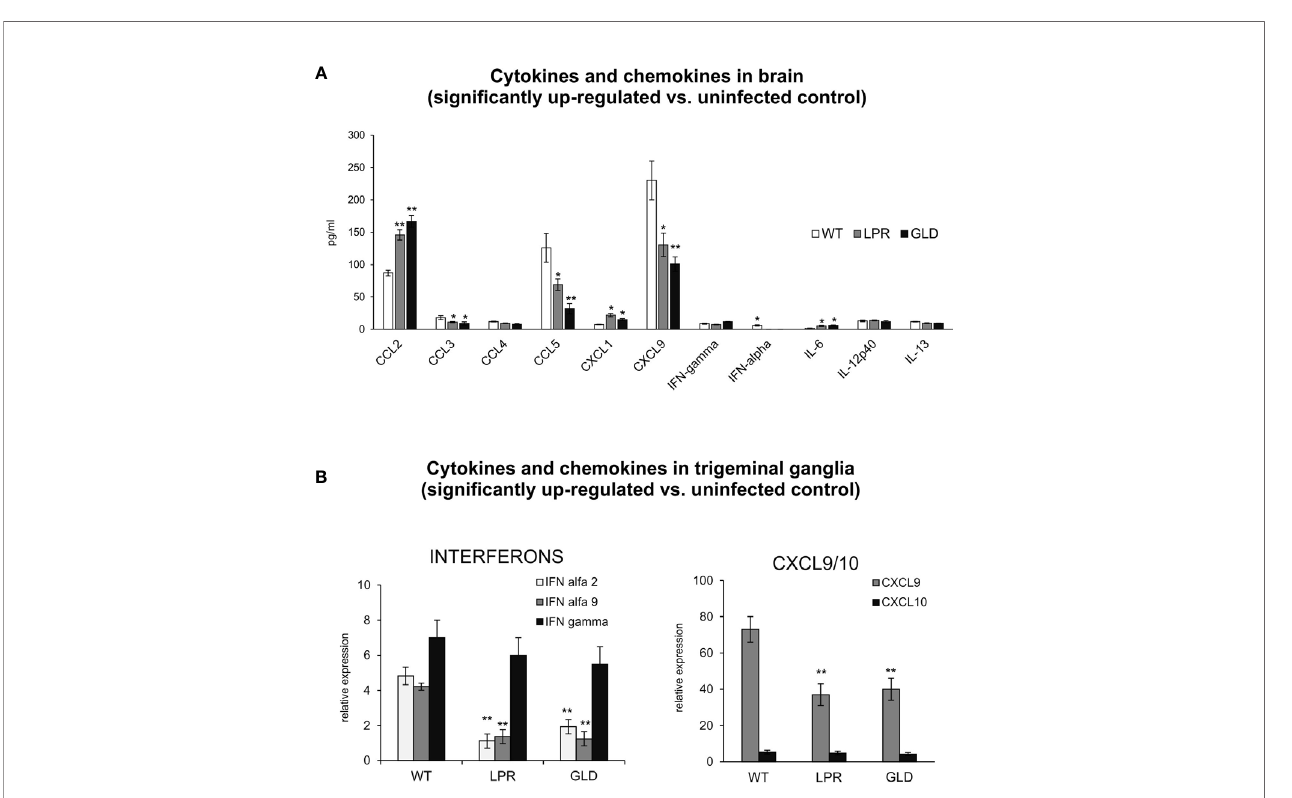
FIGURE 4 | Fas/FasL regulates production of cytokines and chemokines in the HSV-1 infected brain tissue and trigeminal ganglia. (A) Chemokines (CCL2, CCL3, CCL4, CCL5, CXCL1, CXCL9) and cytokines (IFN- a , IFN- g , IL-6, Il-12p40 and IL-13) in the brain tissue at 8 d p.i. were analyzed by Luminex. Data were presented as mean ± SEM, N = 4. Data analysis was performed by comparing Fas-de fi cient (lpr) and FasL-de fi cient (gld) groups with wild-type (C57BL/6) mice. **p ≤ 0.001, *p ≤ 0.05. (B) Interferons (IFN- a 4, IFN- a 9 and IFN- g ) and chemokines (CXCL9 and CXCL10) in trigeminal ganglia of wild-type, lpr and gld mice at 8 d p.i. were measured by quantitative real-time PCR. Data were present in mean ± SEM, N = 4. **indicates P ≤ 0.001, while *P ≤